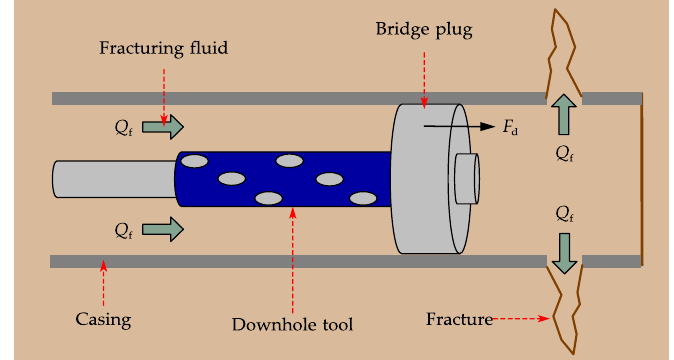
Figure 3. Schematic of a pump-in downhole tool.